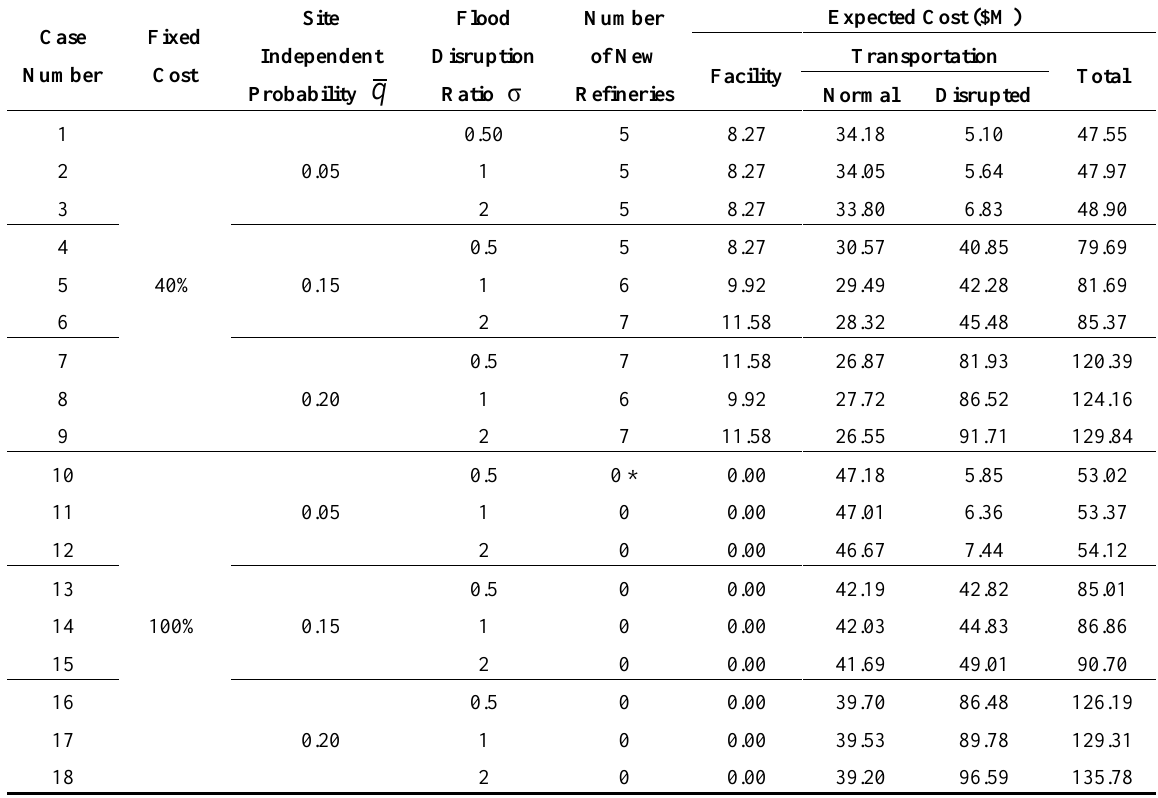
Table 5. Sensitivity of optimal solutions to flood disruption ratio σ